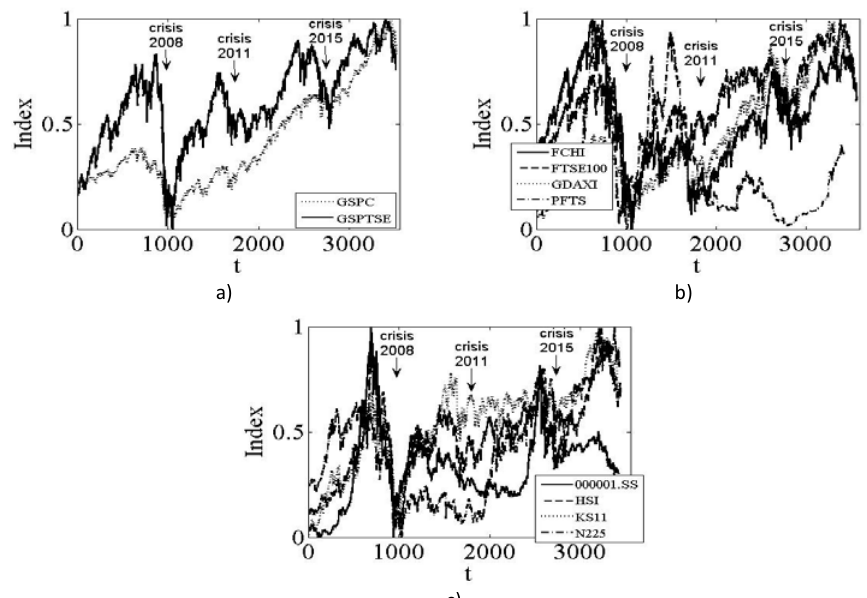
Fig. 2: Dynamics of stock market indices for the countries: (a) the United States, Canada; (b) France, the United Kingdom, Germany and Ukraine; (c) China, Hong Kong, Korea, Japan